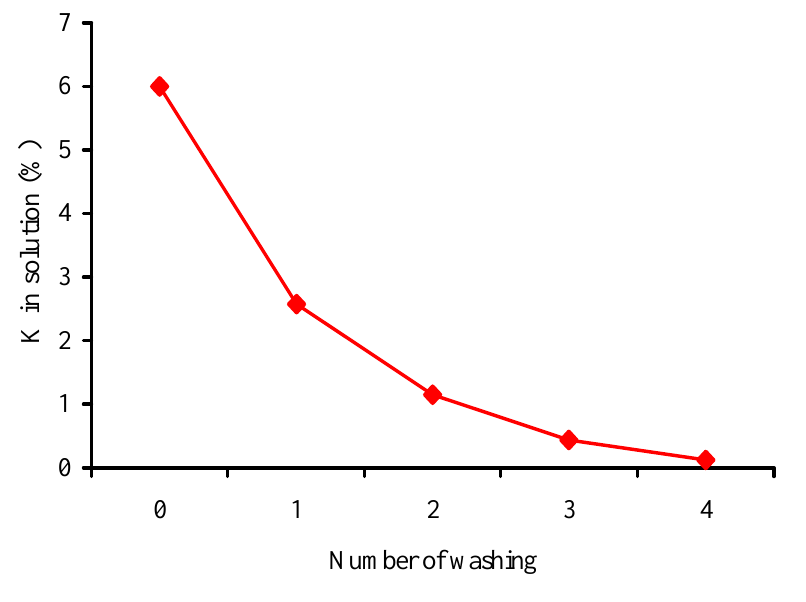
FIGURE 1 . Effect of washing on K removal from HA.